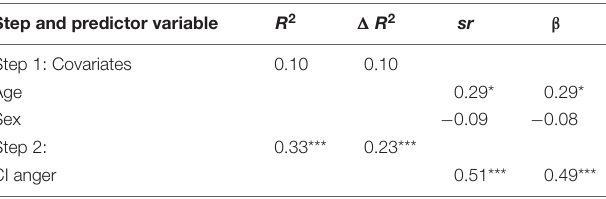
TABLE 3 | Hierarchical multiple regression on the prediction of withdrawn behavior by CI